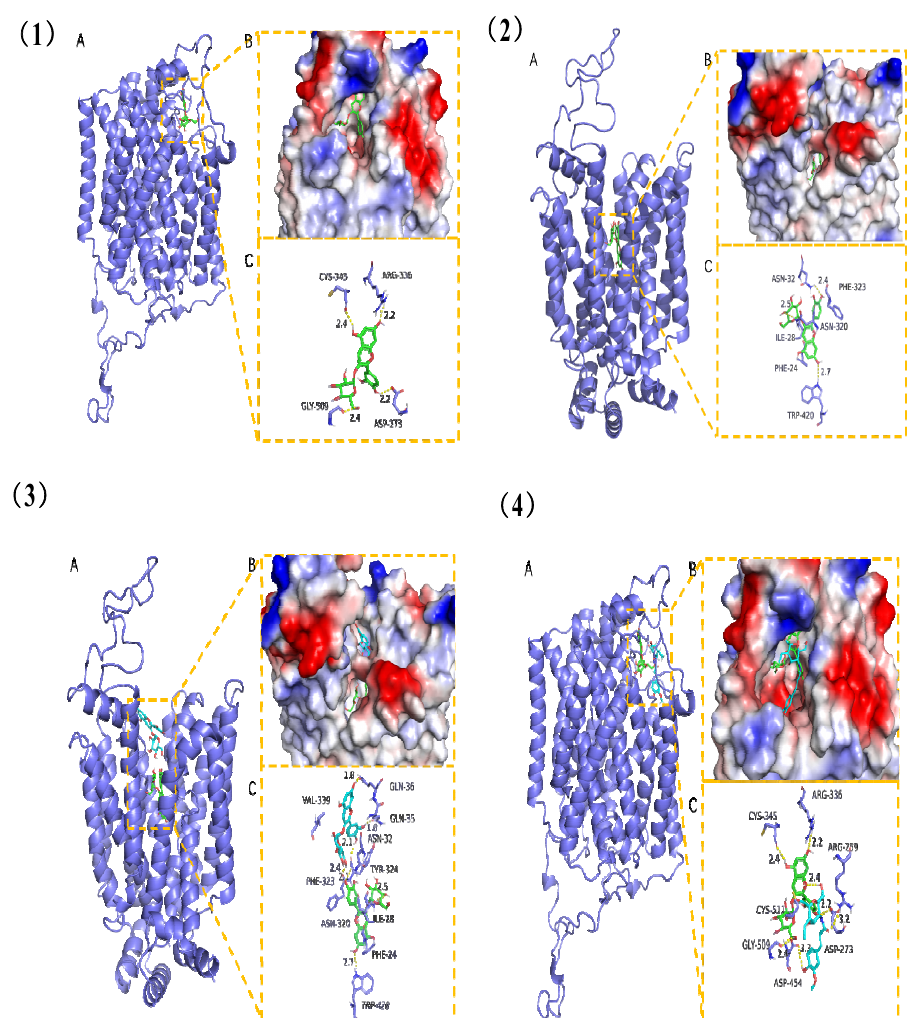
Figure 6. ( 1 ) The combination mode of ANC with sGLT1 . (A) The 3D structure of ANC- sGLT1 com- plex. (B) The surface detail of active site. (C) The detailed combination mode of ANC- sGLT1 com- plex. The shape of the backbone of the protein is tubular and green in color. The compound is ren- dered by green. Yellow dash represents the hydrogen bond distance. ( 2 ) The combination mode of ANC with GLUT2 . (A) The 3D structure of the complex. (B) The surface detail of the active site. (C) The detail binding mode of the ANC- GLUT2 complex. The shape of the backbone of the protein is tubular and green in color. The compound is rendered by blue. Yellow dash represents the hydro- gen bond distance. ( 3 ) The combination mode of ANC+FA-g-CS with sGLT1 . (A) The 3D structure of the ANC+FA-g-CS- sGLT1 complex. (B) The surface detail of the active site. (C) The detailed com- bination mode of the complex. The shape of the backbone of the protein is tubular and green in color. The compounds are rendered by green (ANC) and blue (FA-g-CS). Hydrogen bond distance is rep- resented by a yellow dash. ( 4 ) The combination mode of ANC+FA-g-CS with GLUT2 . (A) The 3D structure of the ANC+FA-g-CS- GLUT2 complex. (B) The surface detail of the active site. (C) The detailed combination mode of the ANC+FA-g-CS- GLUT2 complex. The shape of the backbone of the protein is tubular green in color. The compounds are rendered by green (ANC) and blue (FA-g- CS). The hydrogen bond distance is represented by a yellow dash. 4. Discussion It is widely known that ANCs are beneficial to human health due to their natural antioxidant activity [34,35]. Therefore, we believe that it is important to increase knowledge on the ways of increasing their bioavailability. Numerous in vitro and in vivo experiments have proven that the small intestine plays an important role in the absorption and utilization of ANCs [3,36]. Caco-2 cells provide a well-established model for studying